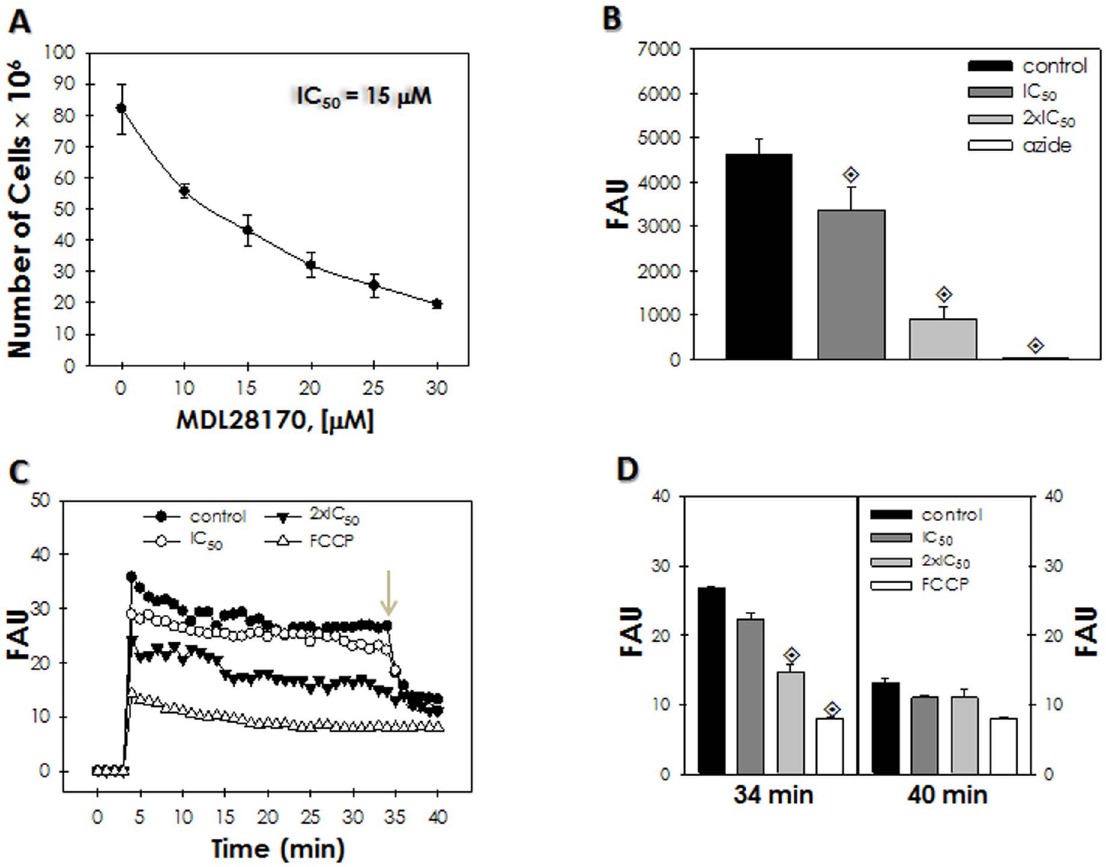
Figure 1. Effects of the calpain inhibitor MDL28170 on Leishmaniaamazonensis promastigotes growth, viability and mitochondrial function. (A) Parasites were treated with different concentrations of the inhibitor and growth was estimated after 72 h. The IC 50 dose was calculated to be 15 m M. All values were significantly different from each other ( P , 0.0001). (B) Graphical representation of the level of resazurin reduction, expressed as fluorescence arbitrary units (FAU), in comparison to control, non-treated cells. Parasites were also treated with sodium azide to obtain non-viable cells. P values were obtained comparing the control cells with the treated groups, and the diamond symbol indicates that P , 0.05. (C) Evaluation of Dy m values (expressed as FAU) after the addition of the JC-1 fluorochrome. The arrow indicates the time point (34 min) at which the uncoupler FCCP was added at 2 m M to collapse mitochondrial potential. (D) Comparison of the Dy m values (expressed as FAU) shown in (C) before (34 min) and after (40 min) the addition of the uncoupler FCCP.